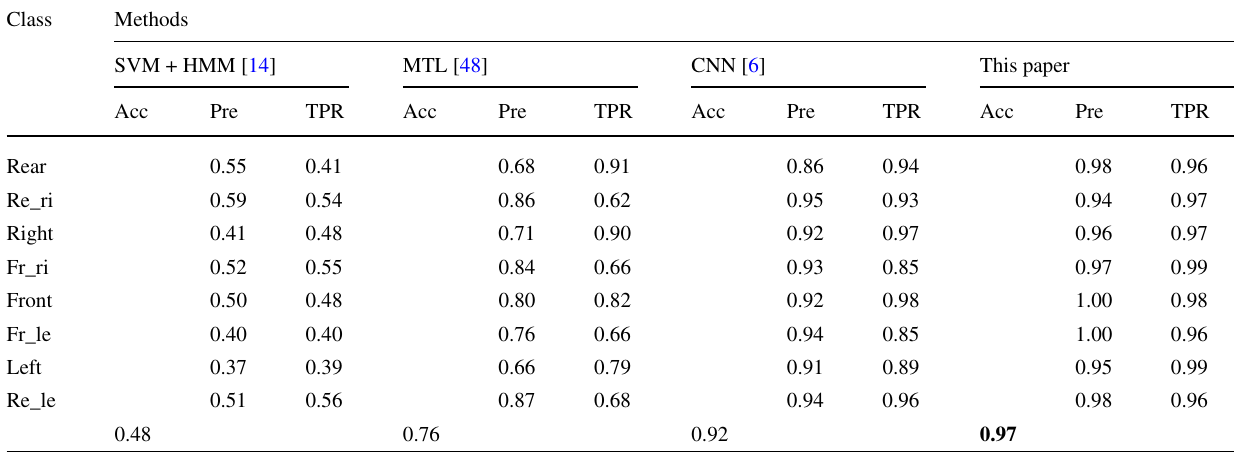
Table 4 Performance comparison of various pedestrian classification algorithms on the PDC data set (with augmented data set) Class